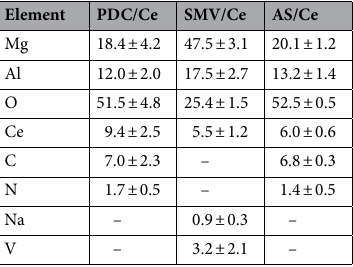
Table 1. Elemental compositions of PDC/Ce, SMV/Ce and AS/Ce specimens in Fig. 6.